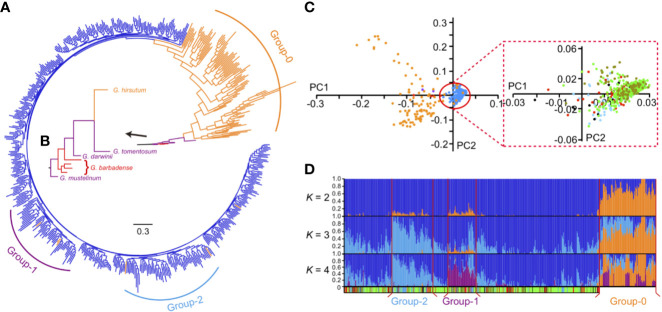
The phylogenetic tree and genetic structure of tetraploid cotton. (A) The phylogenetic tree of all tetraploid cotton accessions. Three distinct groups are marked as purple (Group-1), blue (Group-2) and orange (Group-0) bars. (B) The zoomed view of wild tetraploid cottons and G. barbadense branches. Wilds (purple), G. barbadense (red) and G. hirsutum (orange) branches are marked with different colors, respectively. (C) The principal components analysis (PCA) of all accessions. First two principal components were used as x (PC1) and y (PC2) axis to plot 582 accessions in this study. In left panel, dots with different colors indicated wild species (purple), G. barbadense (red), G. hirsutum landraces (orange) and G. hirsutum cultivars (blue), respectively. In right panel, the red box indicated the zoomed view of PCA plots within G. hirsutum cultivars, different ecotypes including central Asia (deep blue), US (red), Yellow River region of China (green), Yangtze River region of China (asparagus) and other nations (black) were represented by dots with different colors. (D) The model-based clustering analysis with different clusters (K = 2 to 4). The y axis quantifies cluster membership, and the x axis represents the accessions; the order is identical with phylogenetic tree (the root was on the right). Group-1, Group-2, Group-0 and Group-3 (all remaining cultivars) are separated by vertical red lines. The colored bar at the bottom indicates the geographical origin of all accessions, light blue, Central Asia; red, United States; green, Yellow River region of China; asparagus, Yangtze River region of China; black, other nations; white, unknown.